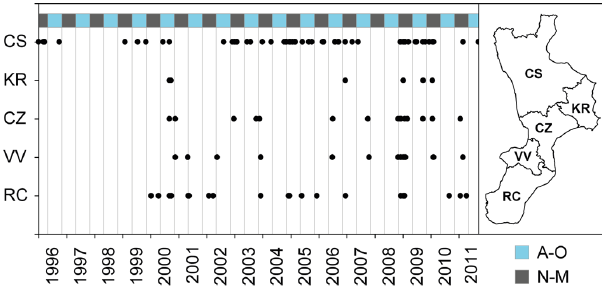
Fig. 2. Time distribution of 186 rainfall events that resulted in 251 landslides in the 16-year period from January 1996 to Septem- ber 2011 in the five provinces of Calabria. Legend: A–O = April to October seasonal period, N–M = November to March seasonal period. CS, Cosenza; CZ, Catanzaro; KR, Crotone; RC, Reggio di Calabria; VV, Vibo